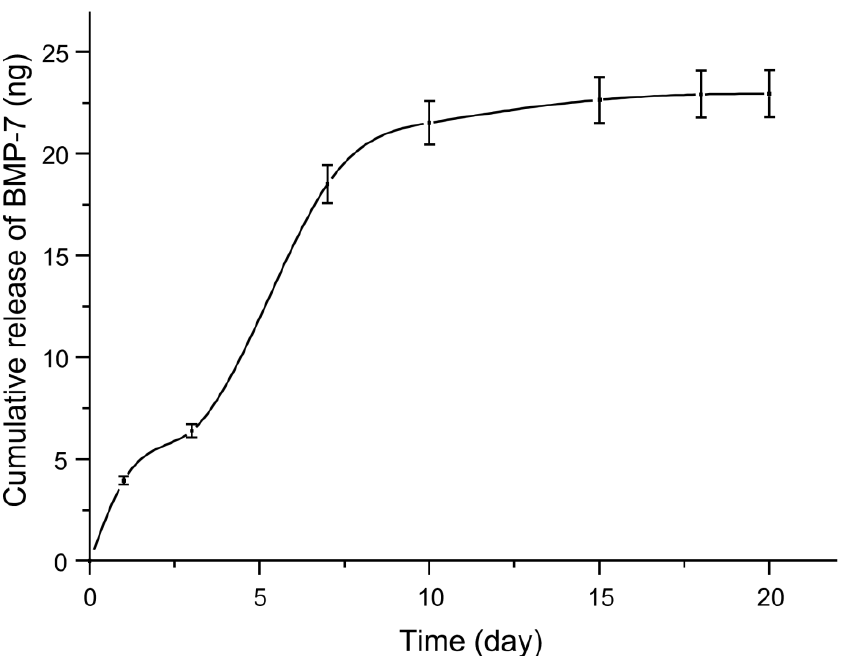
Figure 6. Depicts the in vitro release profile of BMP-7 from a 3D-printed biomaterial scaffold, with each data point representing the mean ( n =